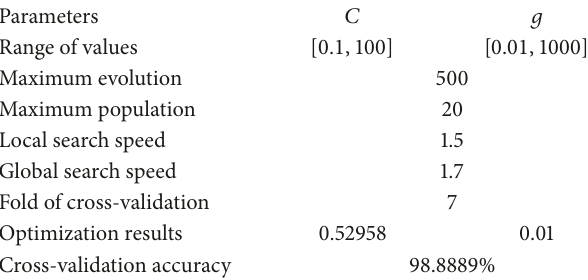
Table 5: Parameters setting and optimization results of